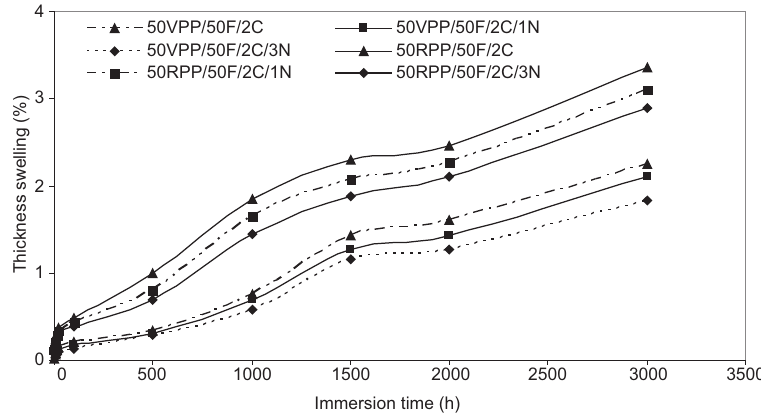
Figure 1 Effect of plastics virginity and the presence of nanoclay on thickness swelling of hemp fiber/PP